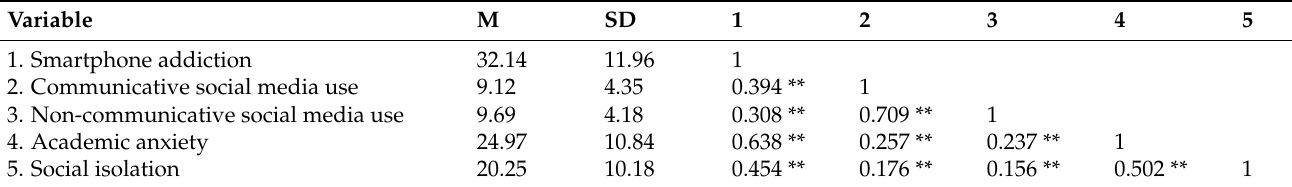
Table 1. The mean, standard deviation, and correlation coefficient for each